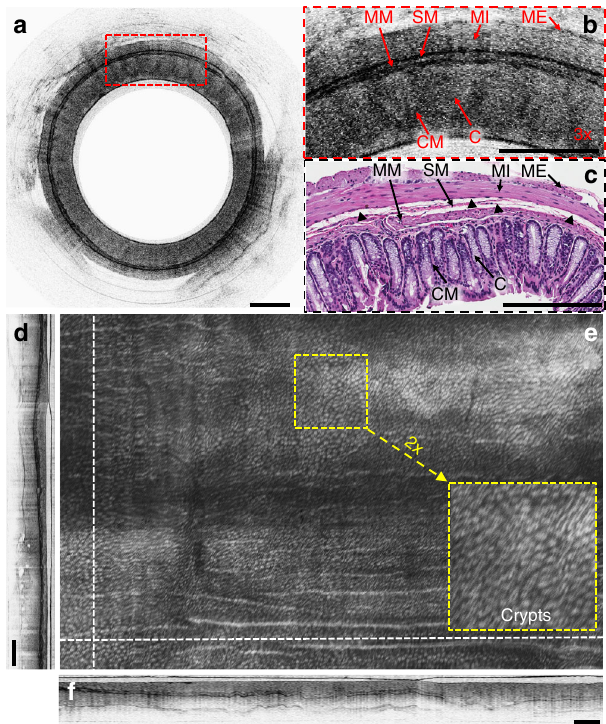
Fig. 5 In vivo imaging of mouse colon. a Representative in vivo two- dimensional (2D) optical coherence tomography (OCT) image acquired by the microprobe. b 3x enlarged view of the area in a , which is boxed by red dashed lines. c Corresponding haemotoxylin and eosin (H&E) histology. e An en face projection view constructed by axial summation of 1.23 mm × 3.04 mm × 5 mm (axial × circumferential × longitudinal) fi eld of view. Inset; 2x enlarged view of yellow dashed box. d , f Cross-sectional images along white dashed lines in e , which correspond to the circumferential and longitudinal direction, respectively. Tissue separations seen in the histology micrograph (labeled with black triangles in c ) are the histology processing artifacts. All scale bars are 250 µ m. C crypt, CM colonic mucosa,